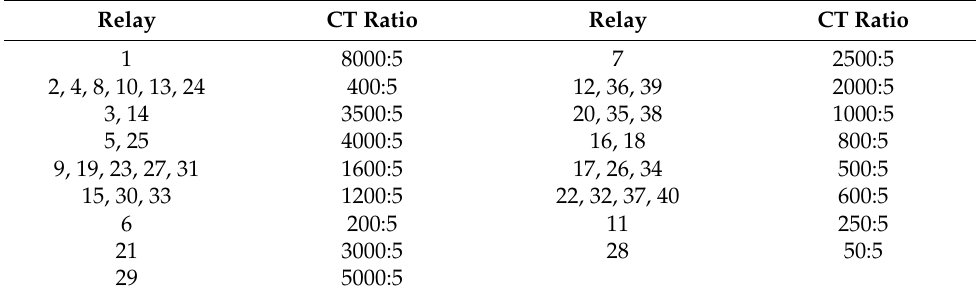
Table 6. CT ratio between the relays for the IEEE 14-bus system.